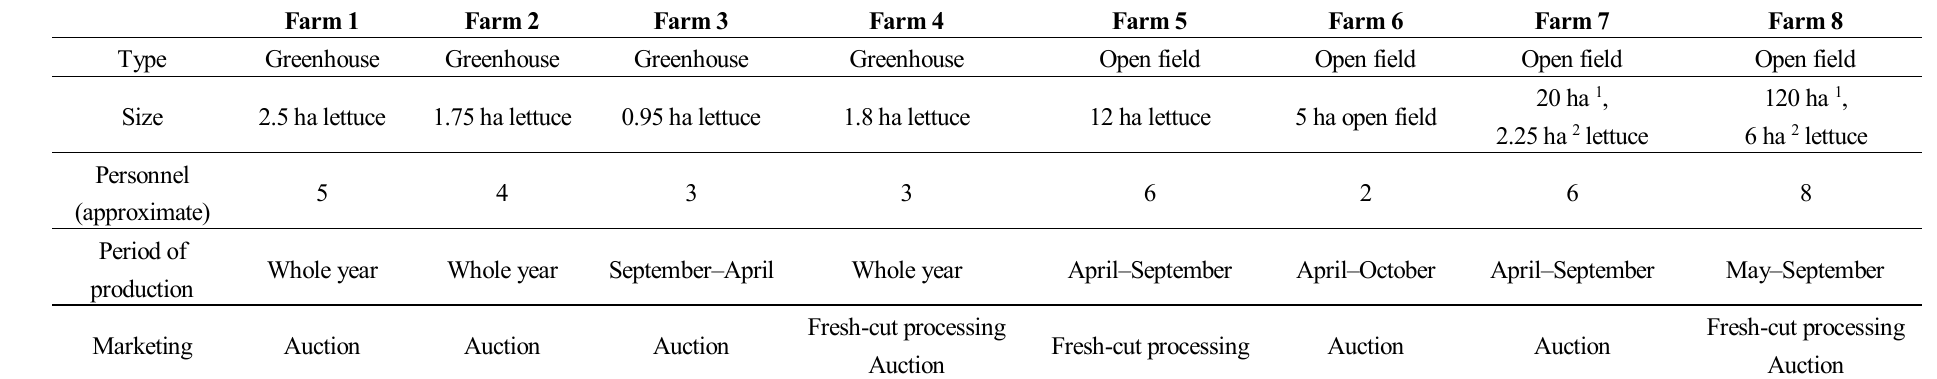
Table 1. Characteristics of the eight farms in West Flanders, Belgium, used in this